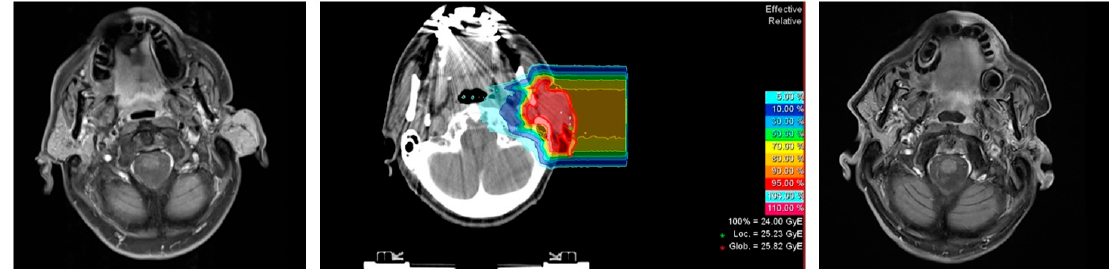
Figure 2. Example of patient with recurrent acinic cell carcinoma rcT2 cN0 cM0; left panel: contrast-enhanced T1-weighted MRI at diagnosis; middle panel: carbon-ion radiotherapy boost plan; right panel: contrast-enhanced T1-weighted MRI at follow-up with local control.